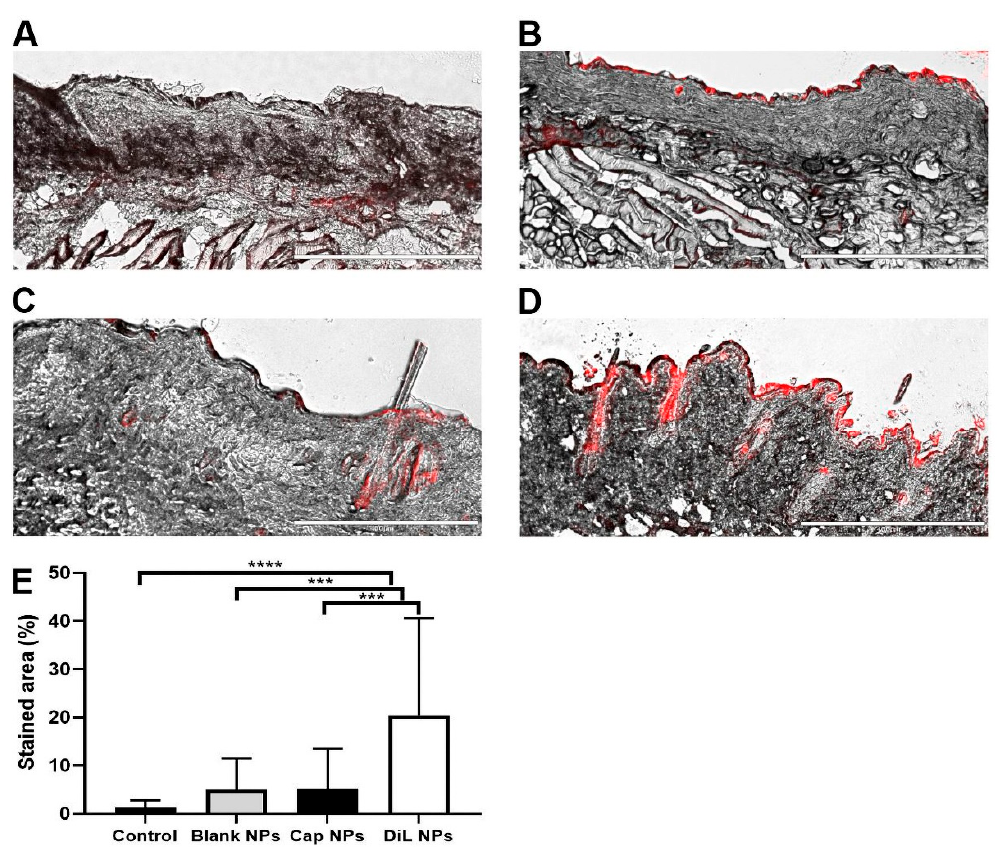
Figure 2. Intracutaneous penetration of NPs topically applied to the skin in the mouse. Exemplary microscope images (Scale bar is 400 µm) of ( A ) a potential autofluorescence (red area) of untreated skin from mouse cheek, ( B ) after treatment with blank NPs, ( C ) after treatment with capsaicin NPs, ( D ) treated with red dye ( red area) containing DiL NPs. ( E ) Mean values of red color measured in cheek tissue from 18 samples per group. *** p < 0.001, **** p < 0.0001, mean ± SD, one-way ANOVA with Bonferroni correction.